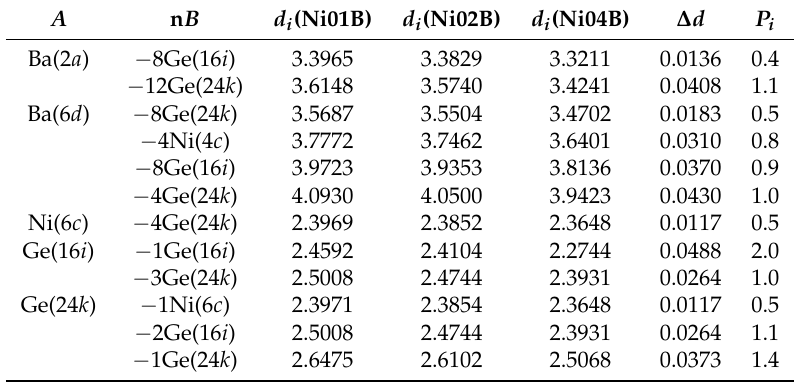
Table 2. Selected interatomic distances (Å, error bar is ∼ 0.0006 Å) for Ni01B, Ni02B, and Ni04B, as well as the distance difference between Ni01B and Ni02B, ∆ d = d i (Ni01B)- d i (Ni02B), where i denotes an interatomic distance such as Ba(2 a )–8Ge(16 i ) and the reduced percentage (%), P i = ∆ d / d i (Ni01B). A n